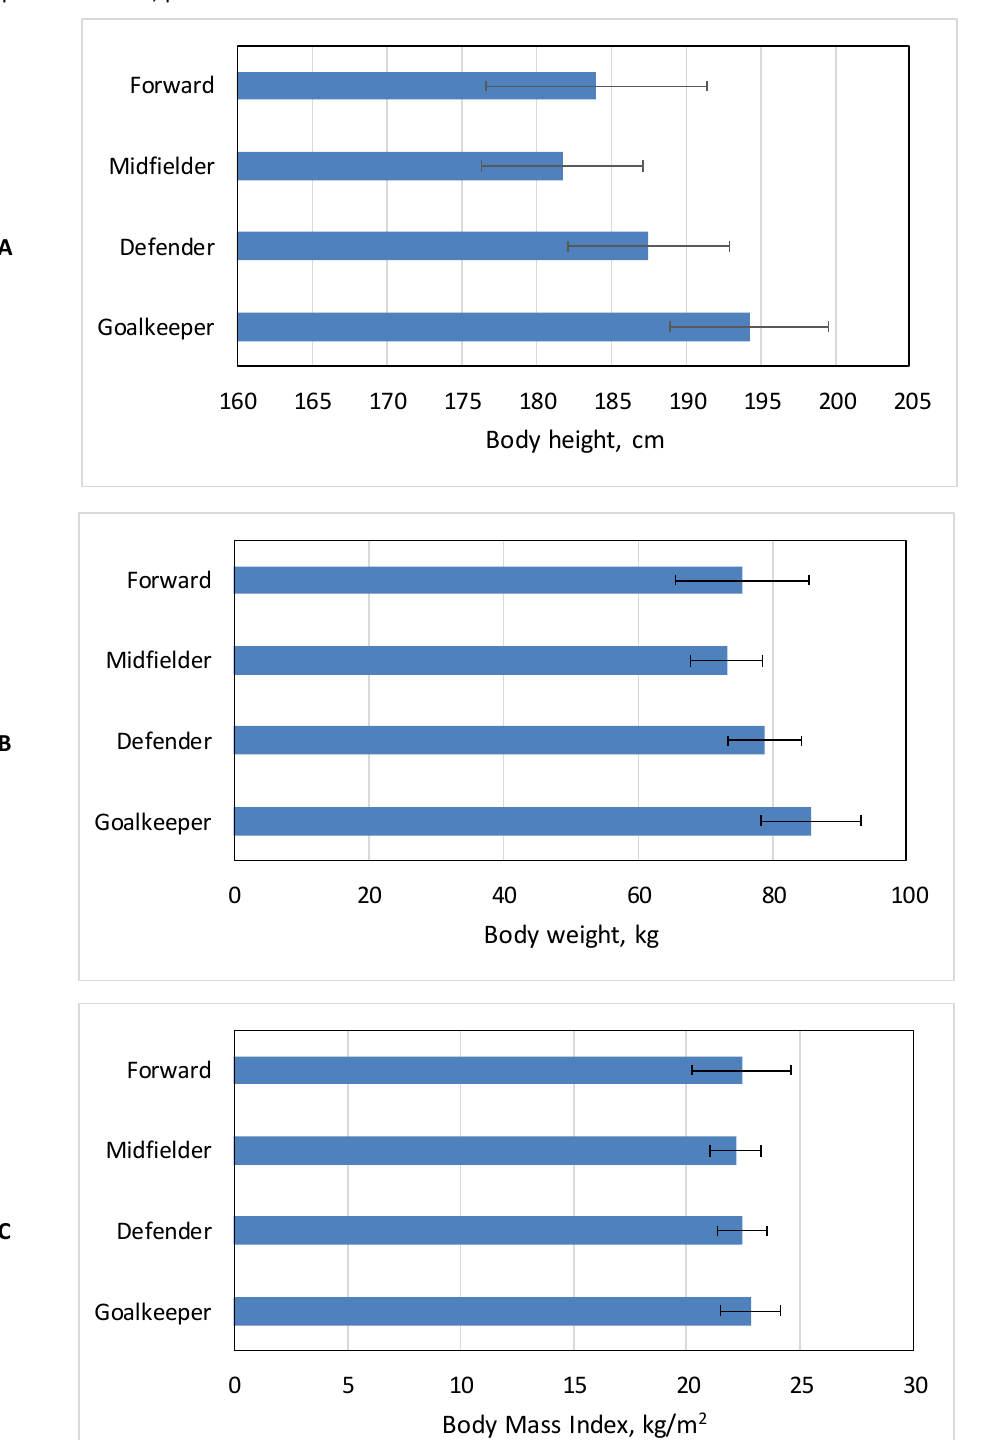
Body Mass Index, kg/m Figure 1. Antropometric characteristics of the soccer players: ( A ) Body height; ( B ) Body weight, ( C ) Body Mass Index.